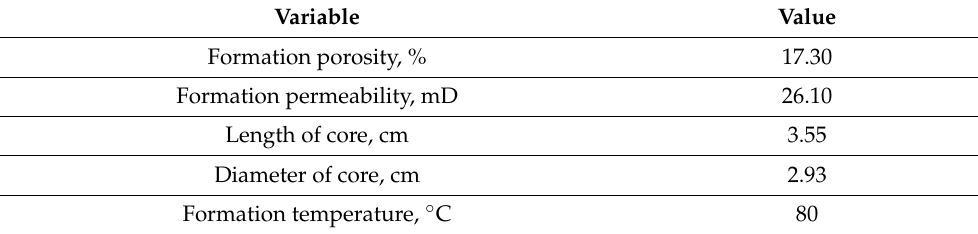
Table 5. Formation properties used for modeling impairment of formation